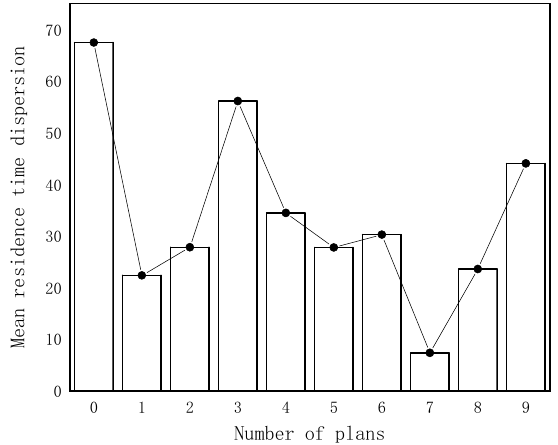
time analysis results.